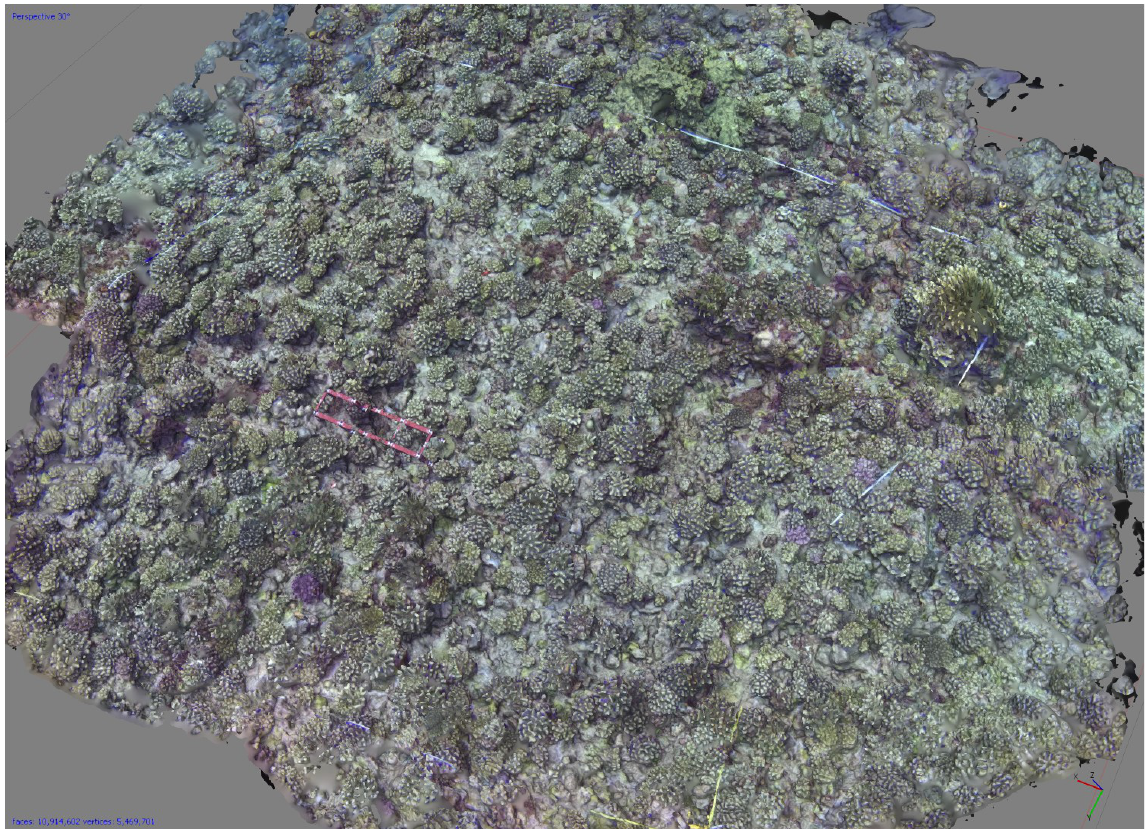
Figure 8. 3D point clouds of a 5m x 5m coral reef patch generated using images from a GoPro underwater